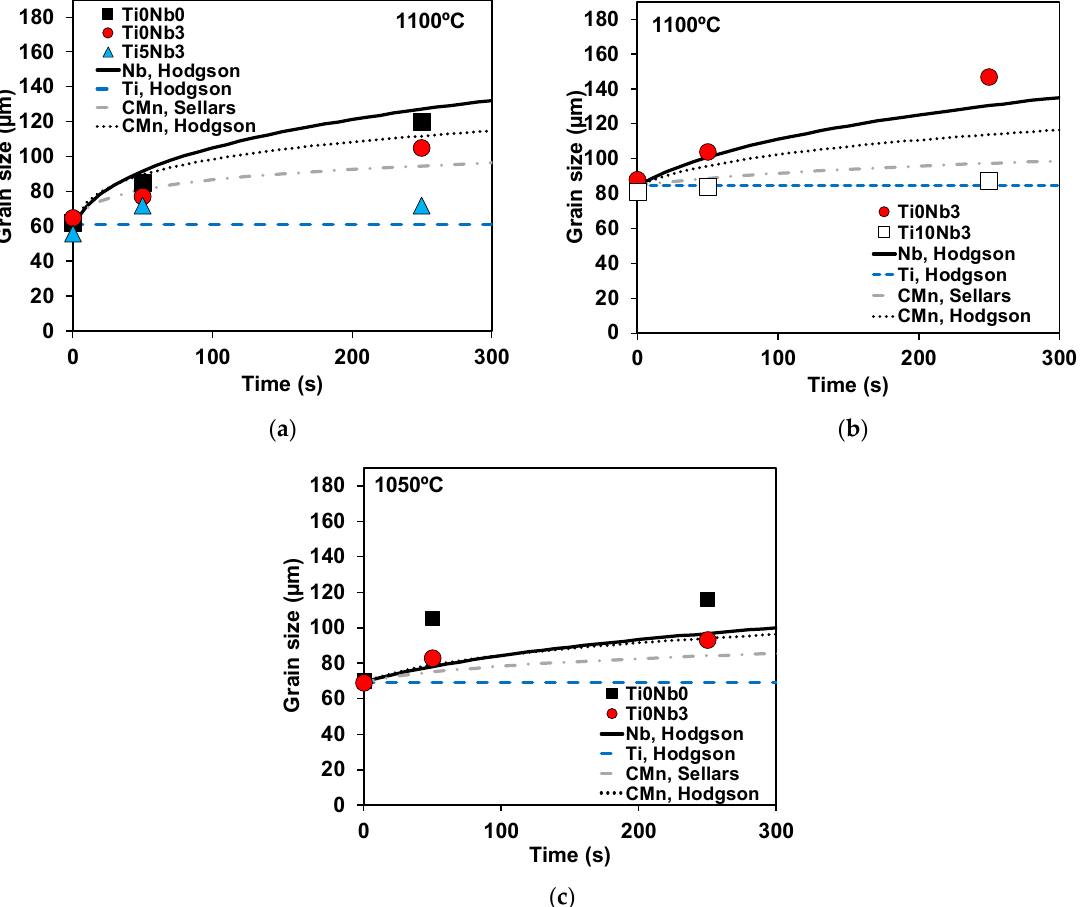
Figure 18. Comparison between the experimental grain growth data and the results of several models reported in the literature (symbols represent experimental data and lines model predictions) at ( a ), ( b ) 1100 °C and ( c ) 1050 °C .